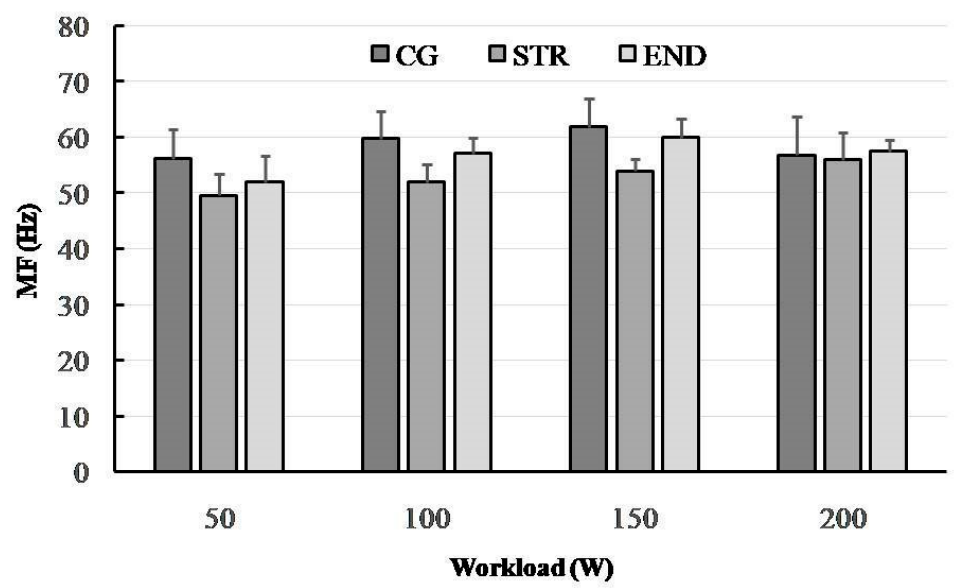
Figure 1. The changes in median frequency (MF) in the research groups (END—triathlon; STR—bodybuilder; CG—recreationally active) during progressive cycling exercise test at subse- quent workloads; point and whiskers—mean ± SD.